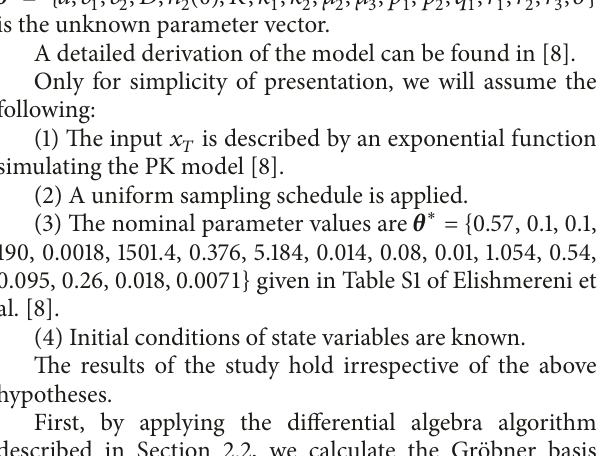
Figure 4: Singular values of the sensitivity matrix of model of (16) obtained with nominal parameter values and reported in decreasing order (the cutoff line at 10 −6 was chosen